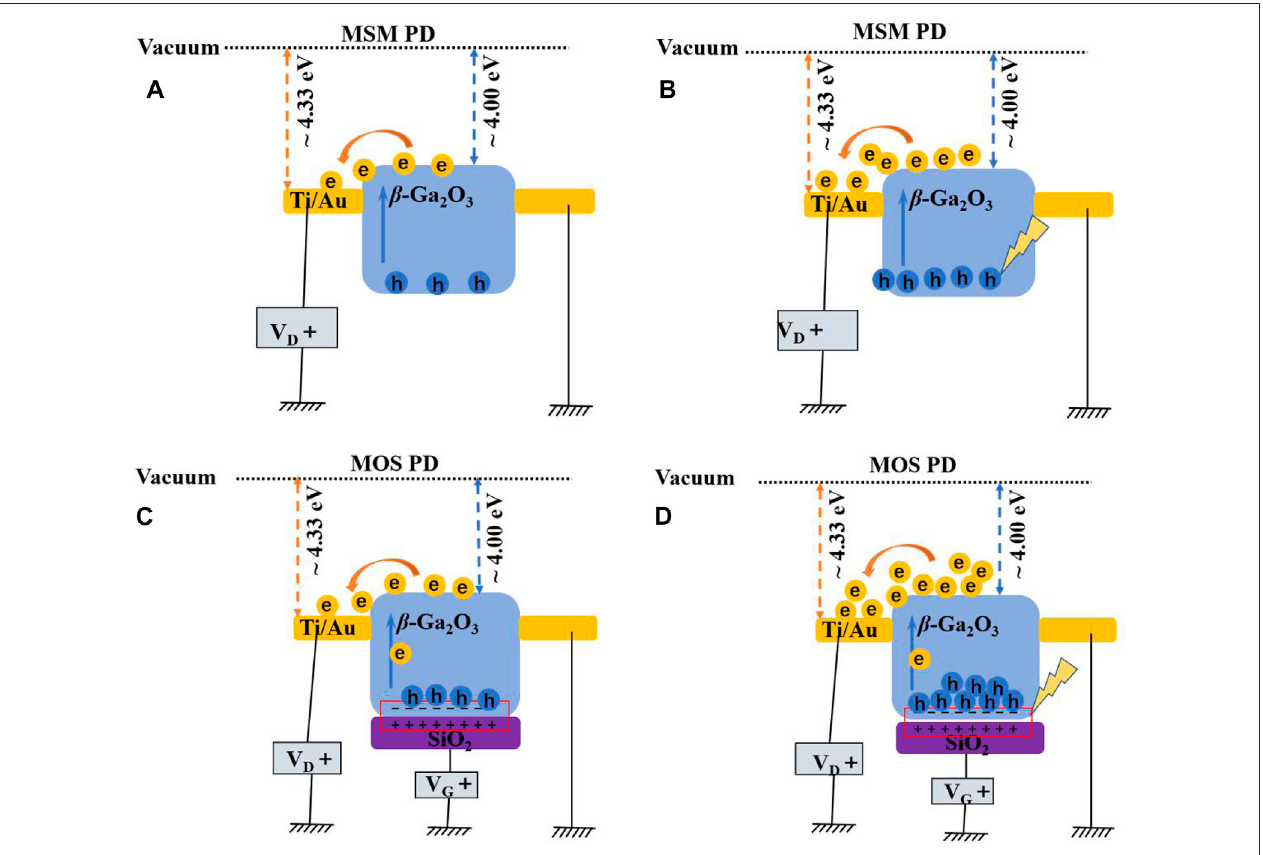
FIGURE 6 | (Color online) The schematic energy band diagram for the (A) Ti/ β -Ga 2 O 3 /Ti structured MSM PDs under dark conditions, (B) Ti/ β -Ga 2 O 3 /Ti structured MSM PDs under illumination, (C) back-gate MOS structure PDs under dark conditions, and (D) back-gate MOS structure PDs under illumination.